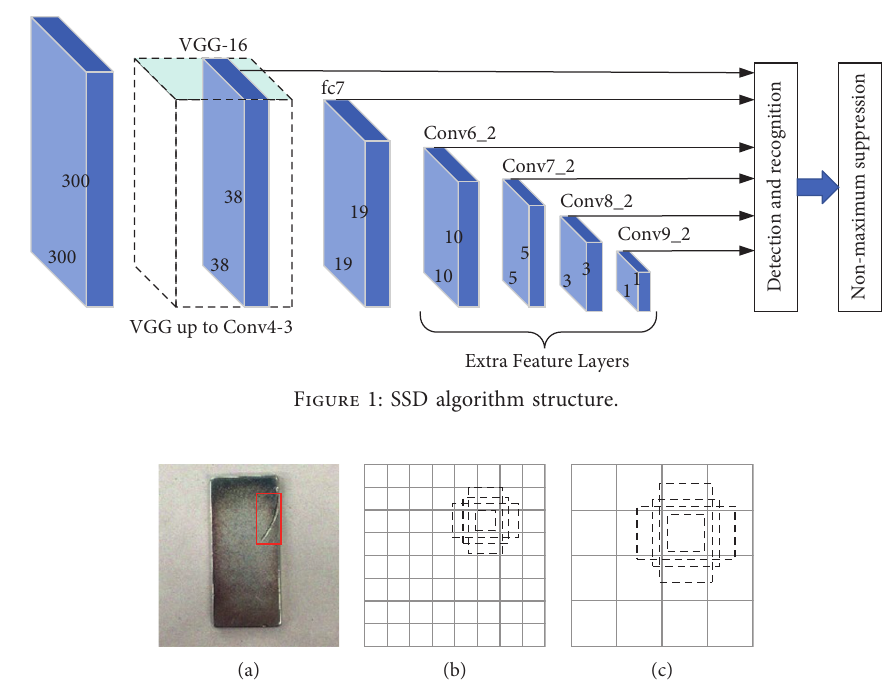
Figure 2: Comparison of the default box and the real box under different scale feature graphs. (a) Image with GT boxes. (b) 8 × 8 feature map. (c) 4 × 4 feature